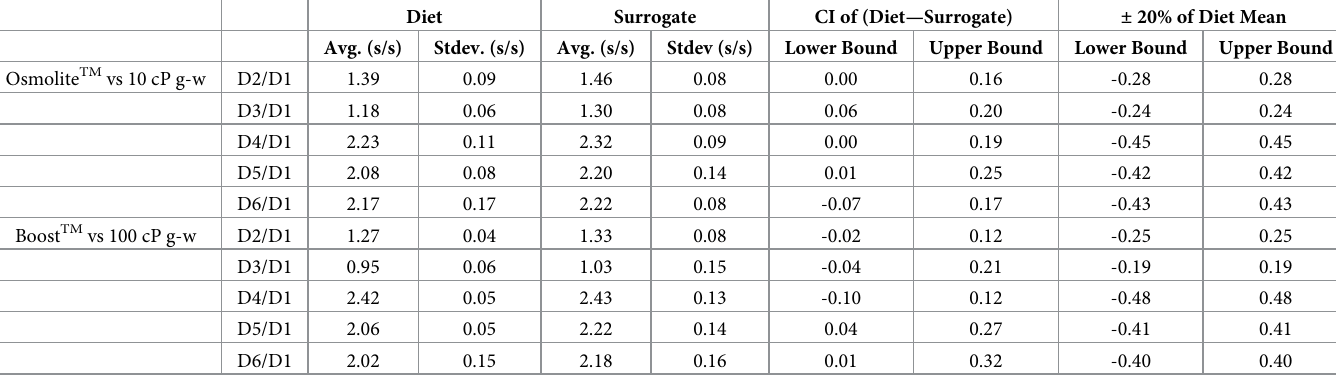
Table 1. Comparison of Osmolite with 10 cP g-w and Boost with 100 cP g-w. Diet